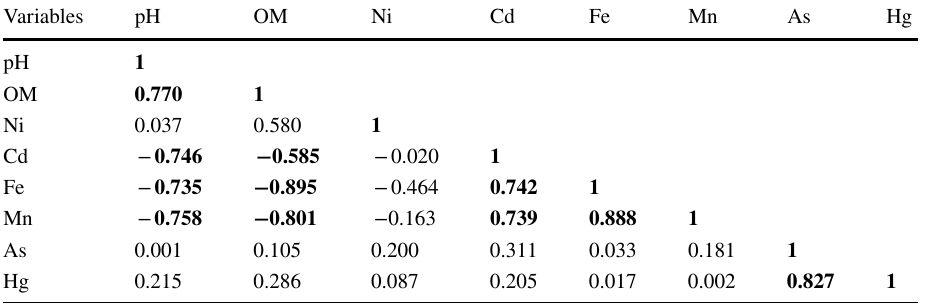
Bold values indicate strong correlations between variables pH Potential hydrogen; OM Organic matter; Ni Nickel; Cd Cadmium; Fe Iron; Mn Manganese; As Arsenic; Hg Mercury Significance level P =